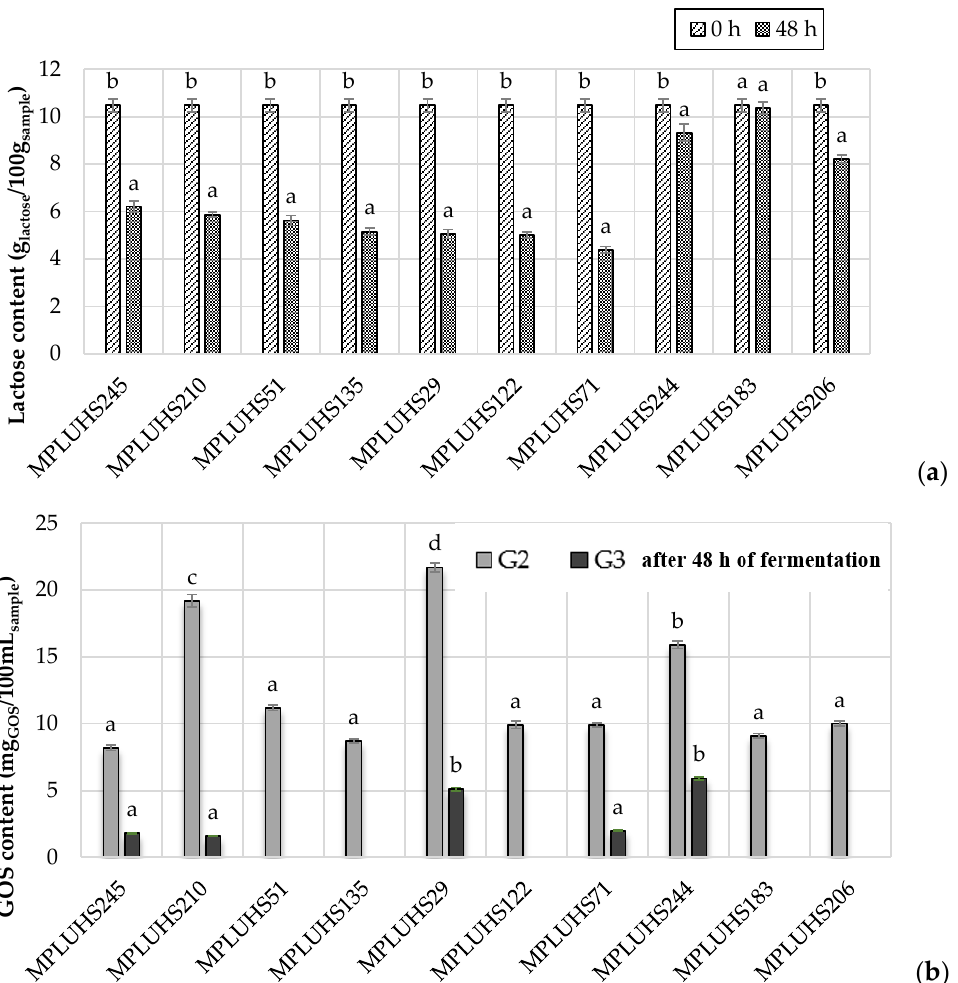
Figure 3. Average values and standard deviations (Mean ± STDV) ( n = 3) of the lactose (g lactose / 100 g sample ) ( a ) and galactooligosaccharides (GOS) (mg GOS / 100 mL sample ) ( b ) content in the milk permeate (MP) (0 h) and / or final fermented beverages (48 h) without the addition of apple by-products. MP—milk permeate; MP LUHS245 —fermented with LUHS245 ( L. uvarum) ; MP LUHS210 —fermented with LUHS210 ( L. casei ); MP LUHS51 —fermented with LUHS51 ( L. curvatus ); MP LUHS135 —fermented with LUHS135 ( L. plantarum) ; MP LUHS29 —fermented with LUHS29 ( P. acidilactici) ; MP LUHS122 —fermented with LUHS122 ( L. plantarum) ; MP LUHS71 —fermented with LUHS71 ( L. coryniformins) ; MP LUHS244 —fermented with LUHS244 ( L. paracasei) ; MP LUHS183 —fermented with LUHS183 ( P. pentosaceus) ; MP LUHS206 —fermented with LUHS206 ( L. faraginis) ;